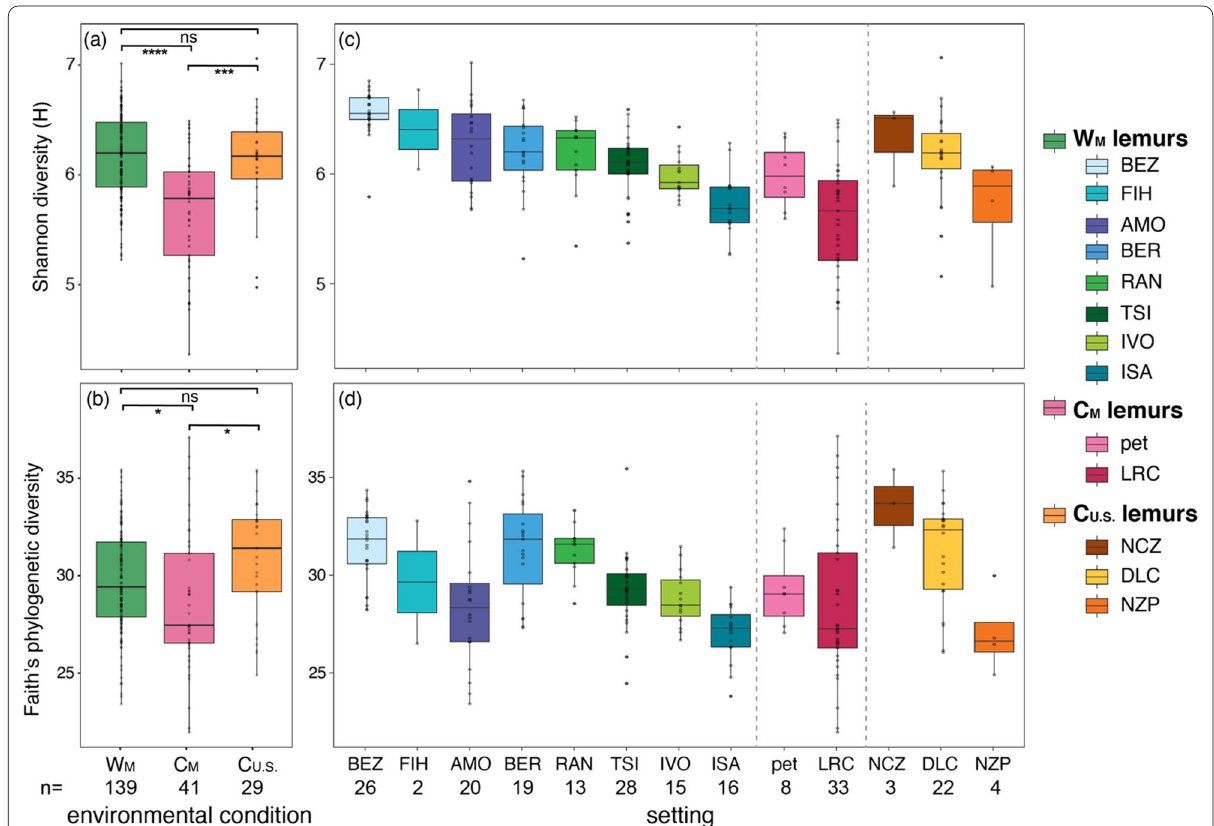
Fig. 1 Alpha diversity metrics of gut microbiota ( a , b ) collapsed by environmental condition, including from lemurs in the wilderness (W M ; green), captivity in Madagascar (C M ; pink), and captivity in the U.S. (C U.S. ; orange), and ( c , d ) averaged across individuals for each of the 13 different settings inhabited (reprising the color codes of each condition, delineated by dashed vertical lines). Shown are both ( a , c ) Shannon diversity and ( b , d ) Faith’s phylogenetic diversity. Across the ( c , d ) settings within an environmental condition (see Table 1 for names of abbreviated study settings), the data are plotted in descending order of mean Shannon diversity. Tukey-style box and whiskers show the median (center horizontal line) and the interquartile range (upper and lower bounds of the box), with outliers that are 1.5 times less than the 25th quartile or 1.5 times more than the 75th quartile. Number of samples (n) is reported below each condition and setting. Kruskal–Wallis test with Benjamini–Hochberg correction; *p <